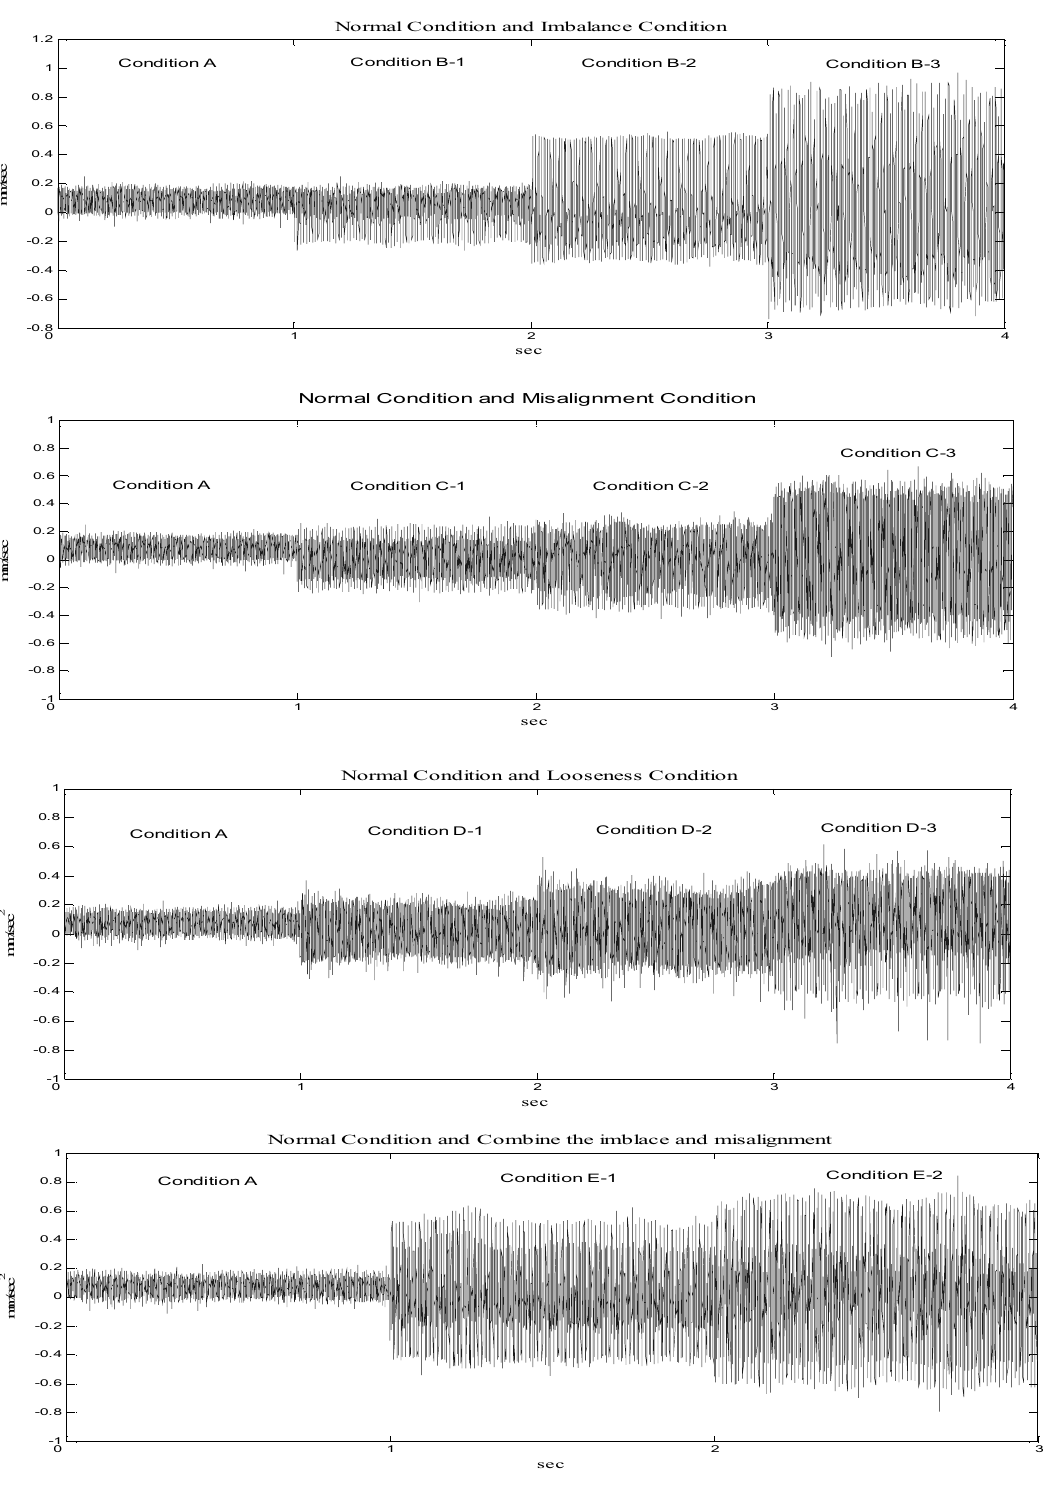
Fig. 7. Vibration signals in time